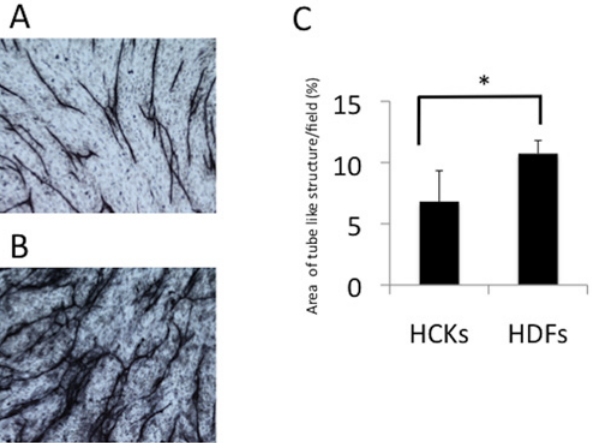
Figure 2. Tube formation by HUVECs co-cultured with corneal cells or dermal fibroblasts under serum-free conditions. The areas of tube formation by HUVECs under the normal serum-free medium conditions were 6.81 ± 1.07% in co-culture with the human corneal keratocytes (HCKs, A) and 10.37 ± 2.52% in co-culture with the human dermal fibroblasts (HDFs, p < 0.0001, B and C). N = 12 per condition.